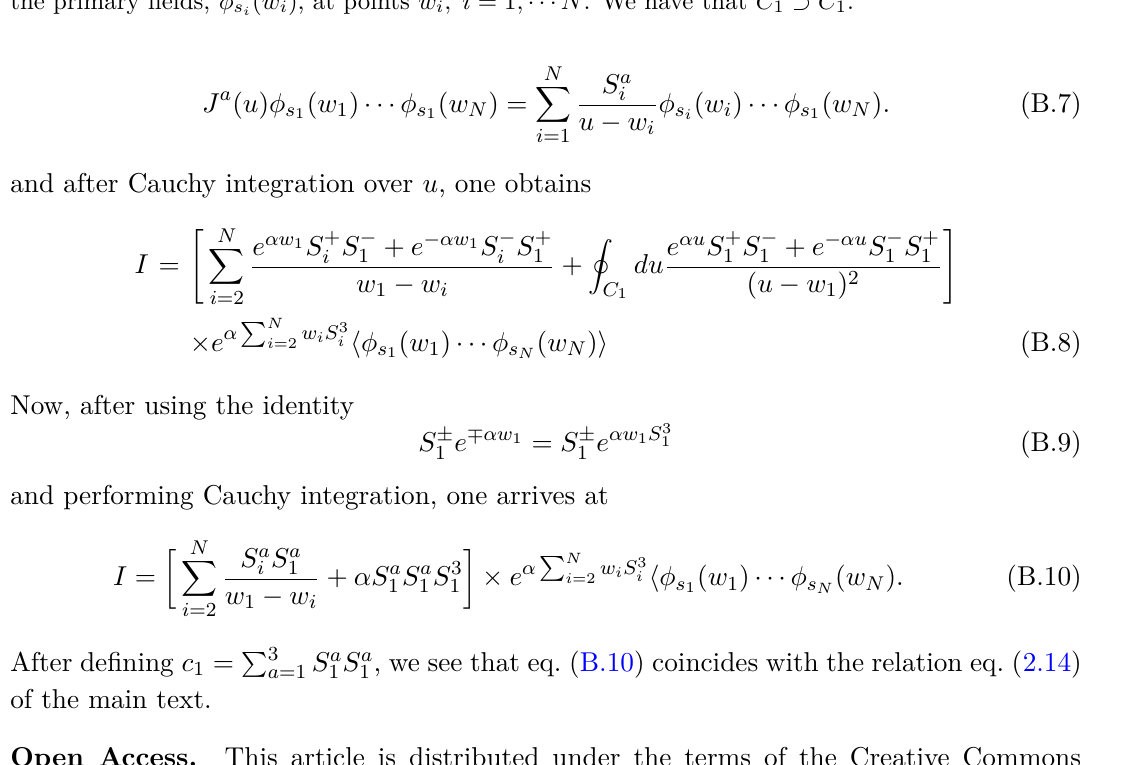
, which they act on − 1